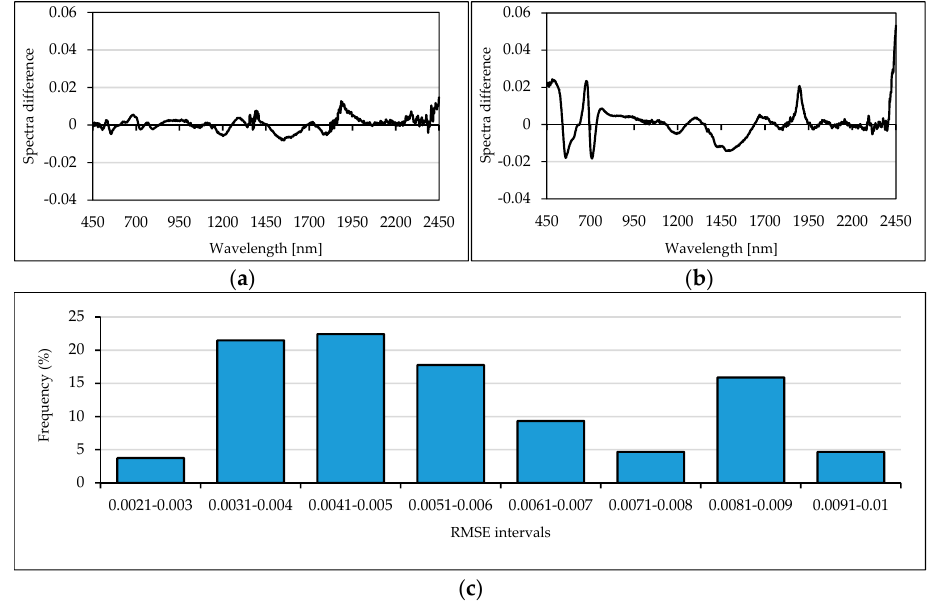
Figure 9. The difference between two simulated and measured canopy spectra on different days of the experiment, ( a ) day 11; ( b ) day 36; and ( c ) the distribution of RMSE between measured and simulated spectra for all simulations.